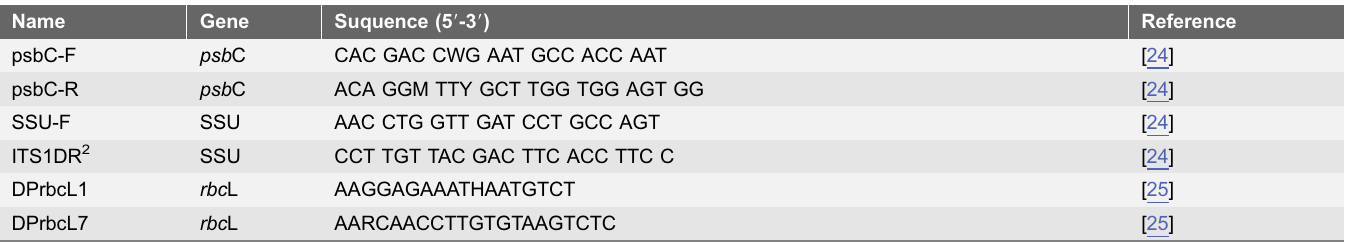
Table 1. Primers used to amplify the SSU, rbc L and psb C